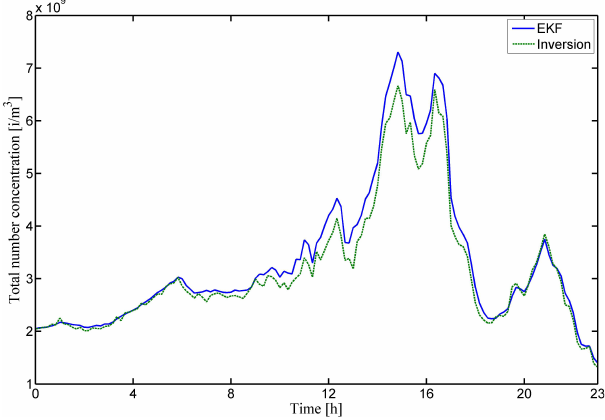
Fig. 2a. Particle size distribution obtained with EKF ( x EKF ) on 7 May 2007 from SMEAR II in Hyyti¨al¨a, Finland. Note that the parti- cle number concentrations are only presented from 10 6 to 10 9 m − 3 . The color bar values are given as exponents of 10. The particle size distribution divided in to time windows I (00:00–09:00LT), II (09:00–17:00LT), III (17:00–19:00LT) and IV (19:00–23:00LT). The black vertical lines represent the time division.